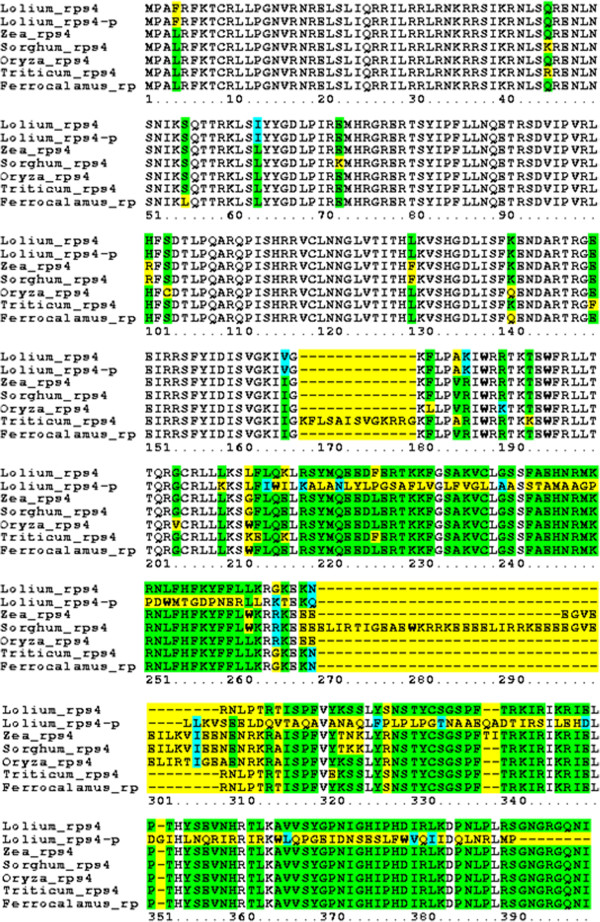
Amino acid sequence alignment of the perennial ryegrass rps4 and rps4-p genes with the rps4 gene of maize, sorghum, rice, wheat and bamboo. Amino acid sequence of the rps4 gene of maize (Acc. No. YP_588274.1), sorghum (Acc. No. YP_762343.1), rice (Acc. No. YP_514660.1), wheat (Acc. No. ADE08097.1) and bamboo (Acc. No. AEK66732.1). Color code: white, conserved; green, identical; cyan, similar and yellow, different residues. This alignment was generated using the SDSC Biology WorkBench [42].